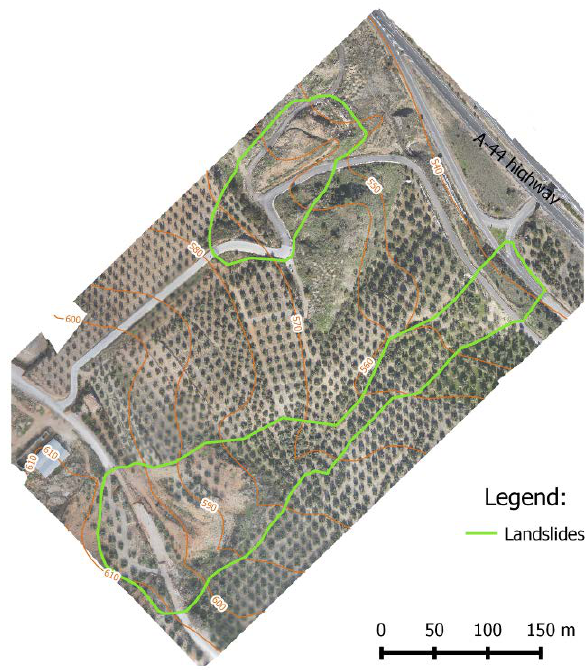
Figure 3. Zone of study and